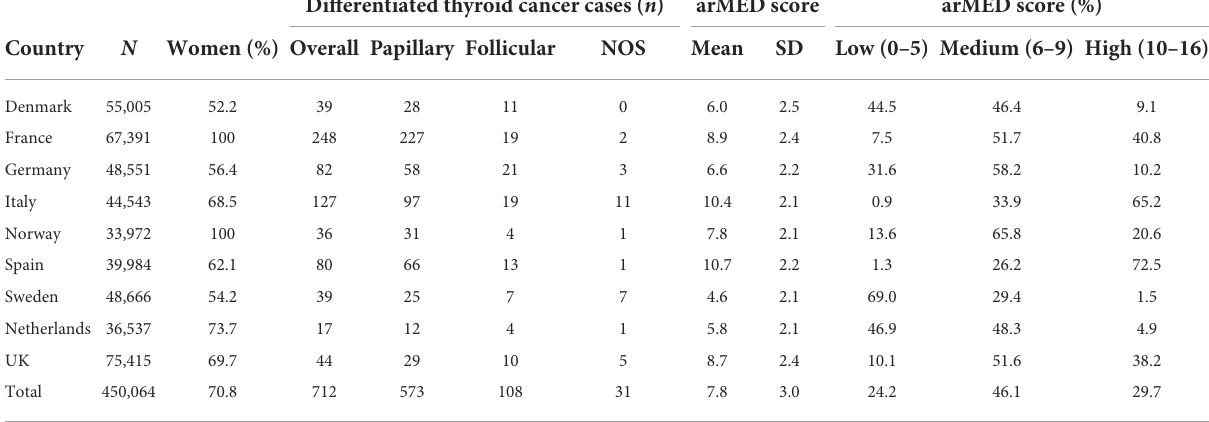
TABLE 1 Description of the EPIC study by country and by adapted relative Mediterranean diet score (arMED). Differentiated thyroid cancer cases ( n ) arMED score arMED score (%) Country